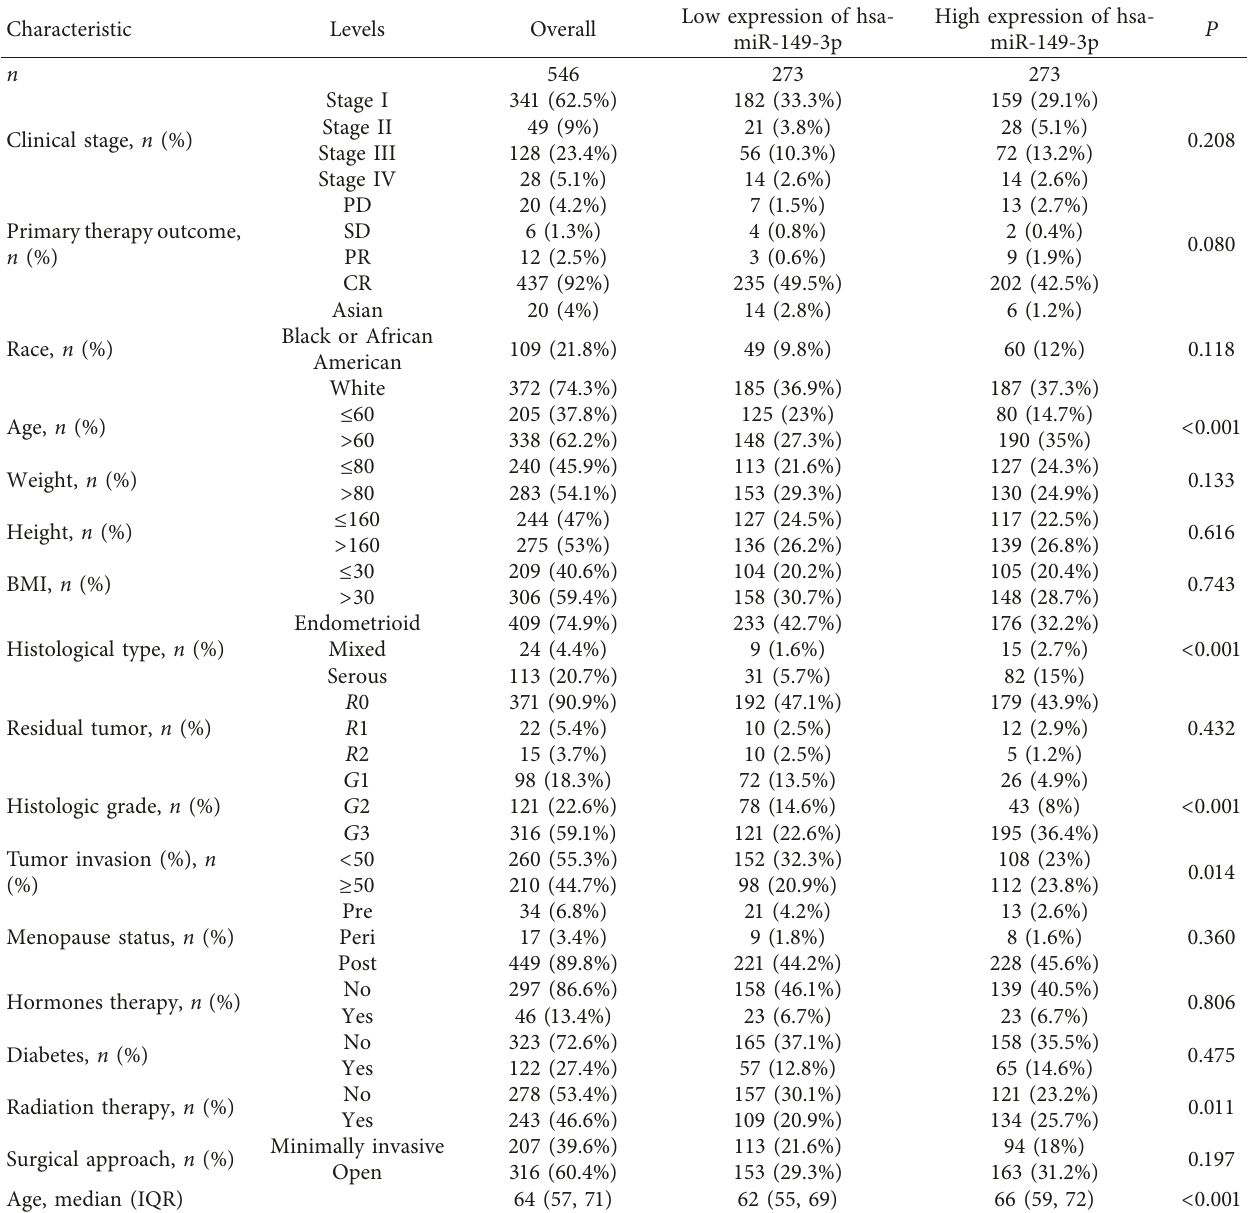
Table 1: Correlation between miR-149-3p expression and clinical characteristics in